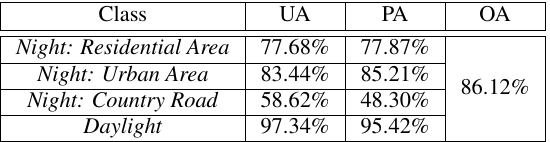
Table 2: Quality measures overall accuracy (OA), user’s accuracy (UA) and producer’s accuracy (PA) for evaluation of the illumi- nation recognition for negative image cutouts.